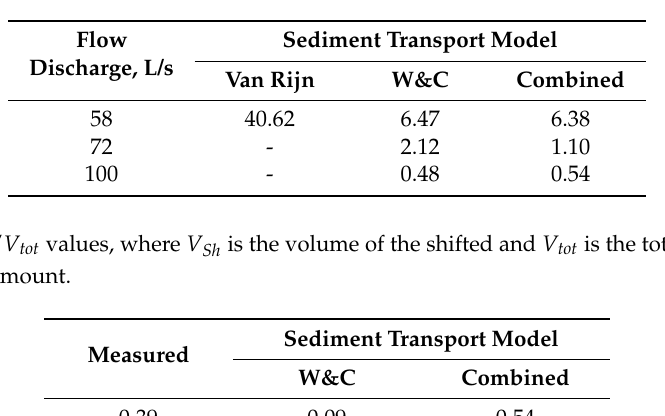
Table 2. The V m / V c values, where V m is the calculated and V c is the measured volume of the deposition form. W&C: Wilcock and Crowe.